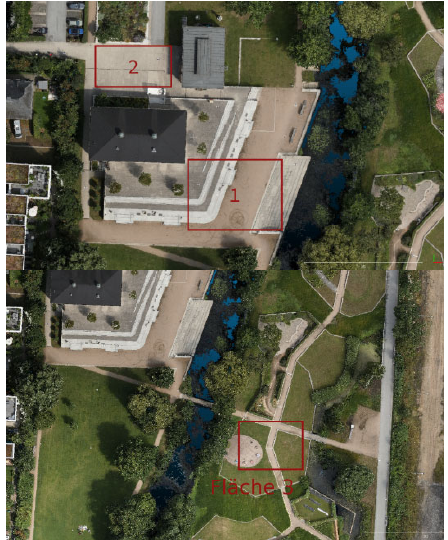
Table 5 . Deviations (  Z) of 3D point clouds of P1 and L1 at Figure 10 . Overview of test areas in the Wilhelmsburg test area 2 for flight 1-5 (Unit Inselpark (outlined in red): Area 1 (paving stones, concrete and sand), Area 2 (smooth paving stones) and Area 3 (wood, sand and lawn).